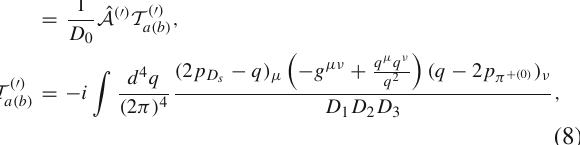
ˆ A ( (cid:3) ) T ( (cid:3) )